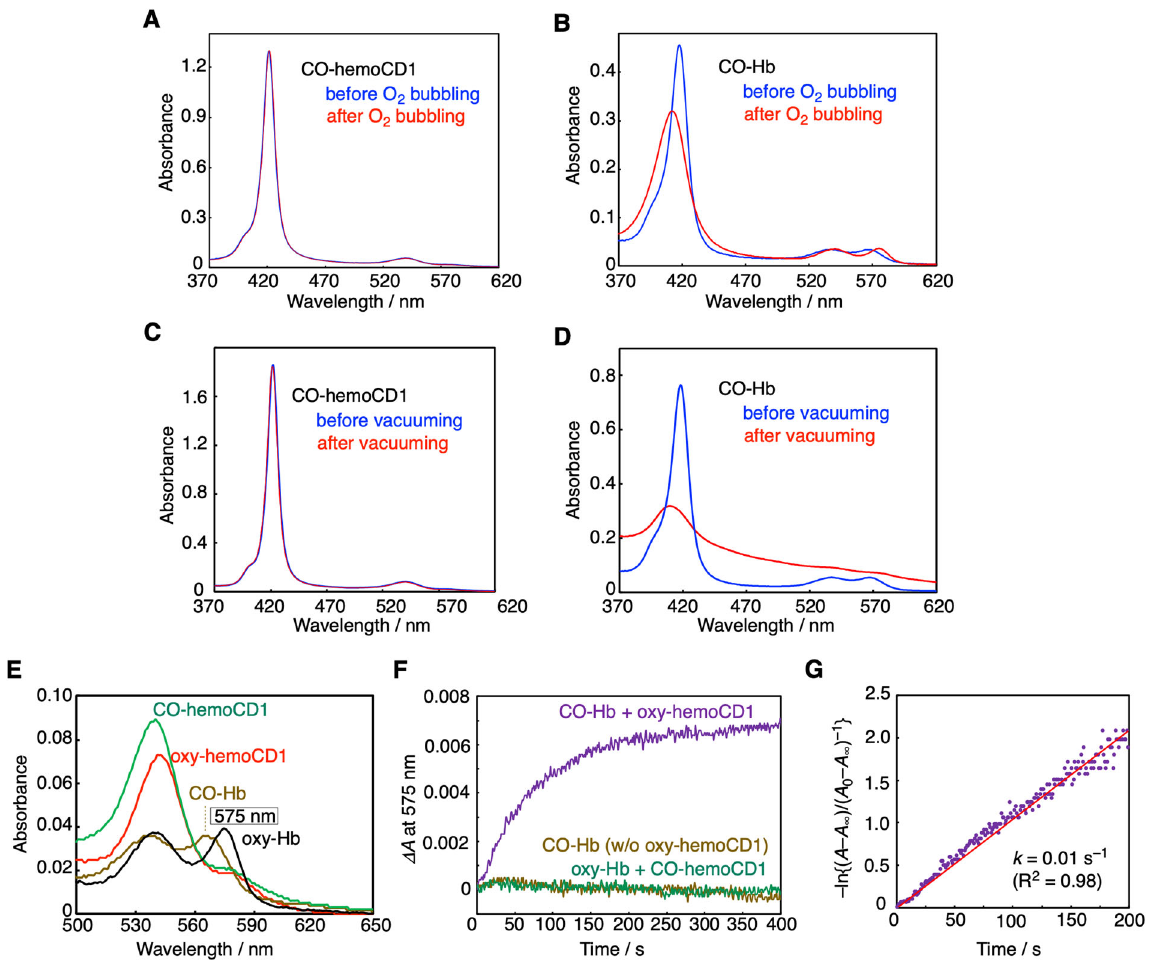
Fig. 2 Characteristics of hemoCD1 as a CO scavenger. UV – vis spectra of CO-hemoCD1 (3.5 μ M, A ) and CO-Hb (2.3 μ M, B ) in PBS at pH 7.4 and 25 °C before (blue) and after (red) bubbling O 2 into the solutions for 5 min. CO-Hb was converted to its O 2 -bound form (oxy-Hb, red line) whereas CO- hemoCD1 was not. UV – vis spectra of CO-hemoCD1 (5.0 μ M, C ) and CO-Hb (3.7 μ M, D ) before (blue) and after (red) vacuuming under 10 Torr for 2 h followed by re-solubilization of the residues. CO-hemoCD1 was stable while CO-Hb decomposed after this treatment. E – G Competition between hemoCD1 and Hb for CO binding. E UV – vis spectra of oxy-, and CO-hemoCD1 (5.0 μ M each), and oxy- (575 nm absorbance peak) and CO-Hb (2.4 μ M each). F Time-course for changes in absorbance at 575 nm, indicative of formation of oxy-Hb, after mixing stock solutions of oxy-hemoCD1 (0.75 mM, 20 μ l in air- saturated PBS) and CO-Hb (0.72 mM, 10 μ l in CO-saturated PBS) in air-saturated PBS (3 ml) at pH 7.4 and 25 °C. Controls are represented by solutions of CO-Hb without (w/o) oxy-hemoCD1, and oxy-Hb mixed with CO-hemoCD1. G First-order rate plot for changes in absorbance at 575 nm over time. The linear regression analysis gave a rate constant of k = 0.01 s − 1